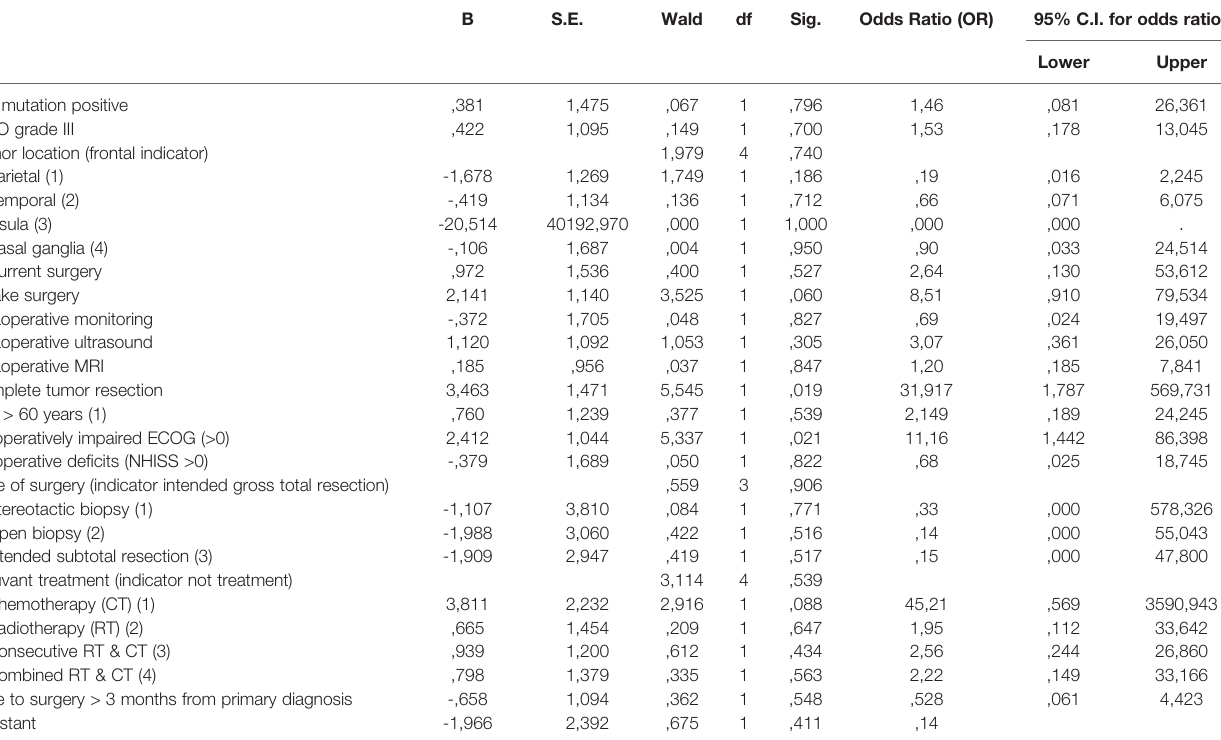
TABLE 4 | Multivariable binary logistic regression for presence of new permanent neurological de fi cits at 3 months follow-up after surgery according to National Institute of Health Score. B S.E. Wald df